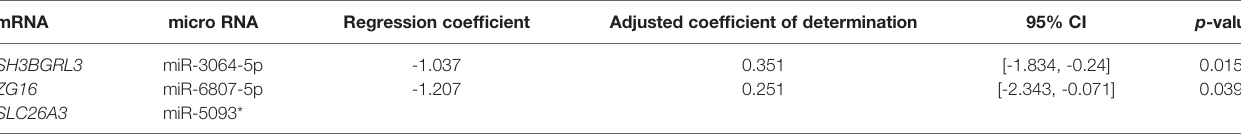
TABLE 2-C | Simple regression analysis between micro RNA and mRNA in colorectal cancer with an MSS phenotype in validation cohort (cohort 2). mRNA micro